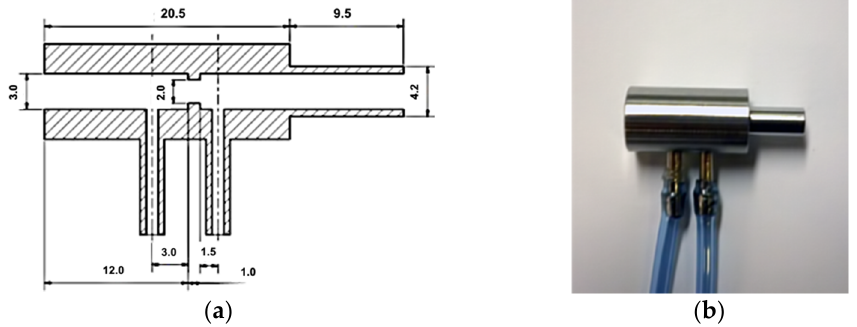
Figure 4. Orifice plate as flow-sensor for HFJV: ( a ) Section and dimensions; ( b ) Realized flow sensor—orifice plate from stainless steel.